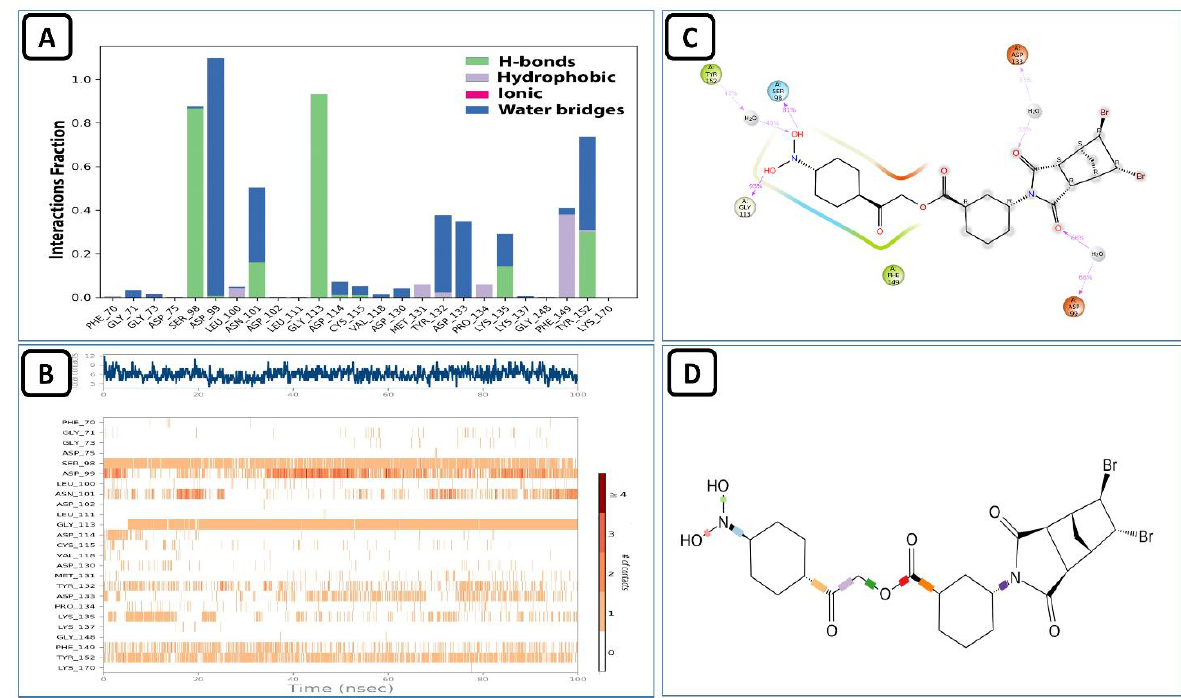
Figure 10. RMSD and RMSF of SARS-CoV-2 MTase and SPECS_AK-918_11684151 complex.